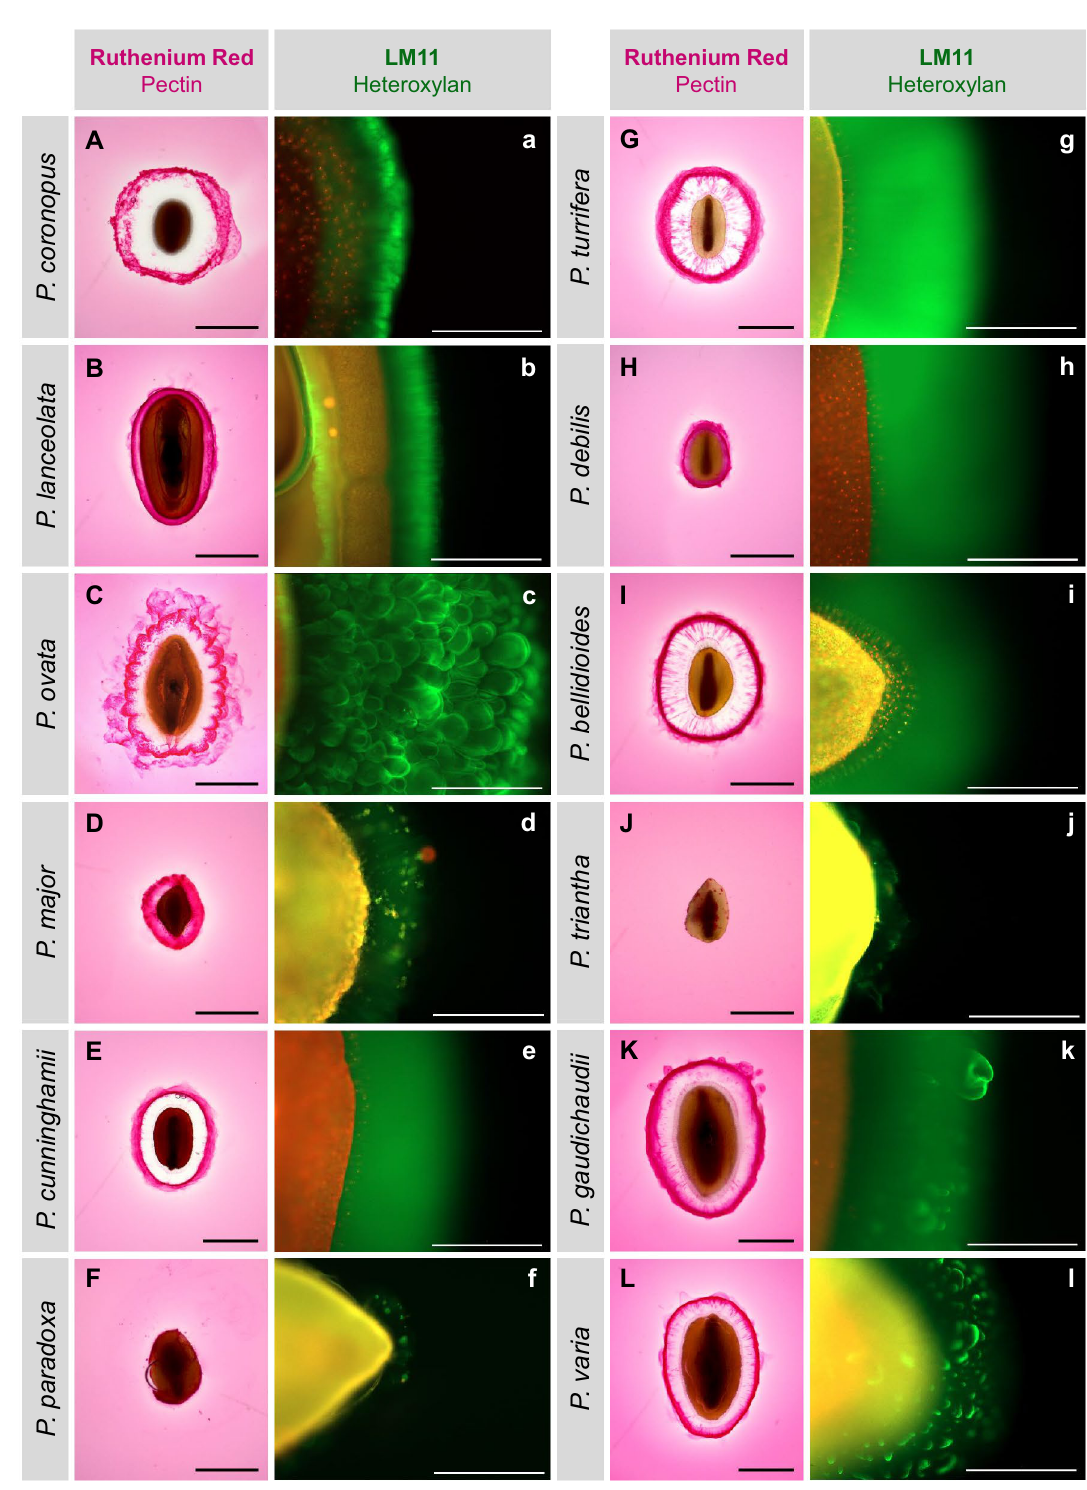
Figure 2. Expanded mucilage architecture of 12 Plantago species. Ruthenium red (dark pink) stains acidic polysaccharides at the mucilage periphery ( A–L ). Scale = 1 mm. Anti-xylan antibody LM11 (green) probes for xylan backbone epitopes in the inner mucilage layers ( a–l ) while the seed is counterstained with propidium iodide (red/yellow). Scale = 500